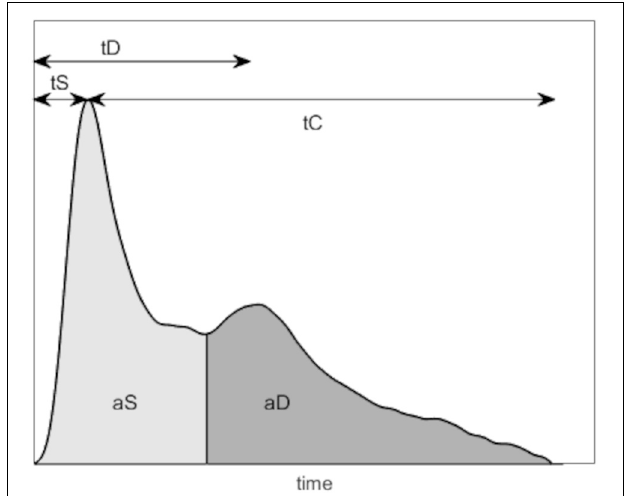
FIGURE 2 | Illustration of the photoplethysmography (PPG) parameters computed. tS, systolic time (s); tD, diastolic time (s); tC, catacrotic time (s); aS, systolic amplitude (mV); aD, diastolic amplitude (mV); aDic, dicrotic notch amplitude